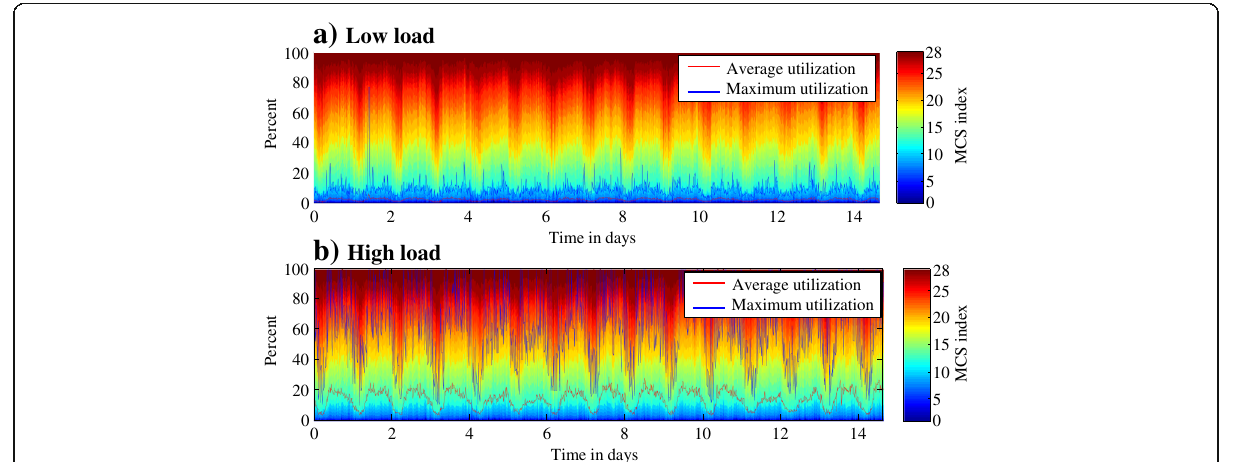
Fig. 3 Measured MCS distribution and maximum and average resource utilization for a low network loads and b high network